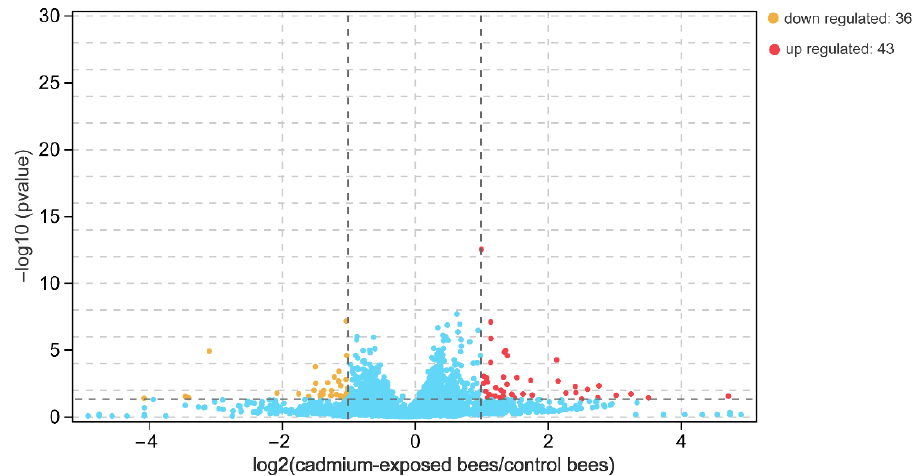
Figure 2. Differentially expressed genes in the brain between cadmium-exposed bees and control bees based on a p -value < 0.05 and an absolute fold-change > 2. Red and yellow indicate the up- and downregulated genes in cadmium-exposed bees, respectively; blue indicates no differentially expressed genes.